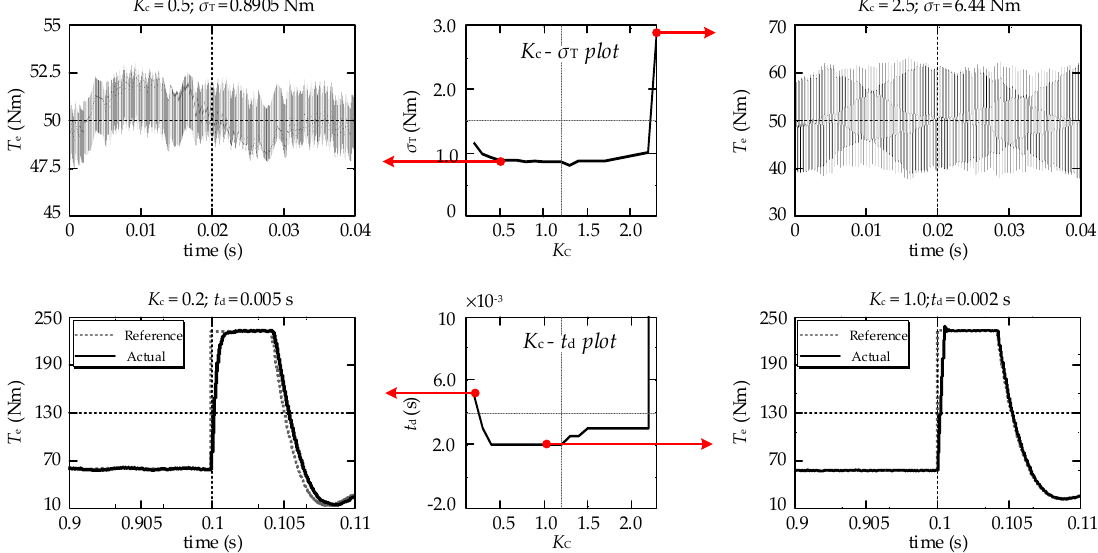
Figure 8. Steady and transient torque performance of the proposed DTC-SVM scheme under different values of K c .